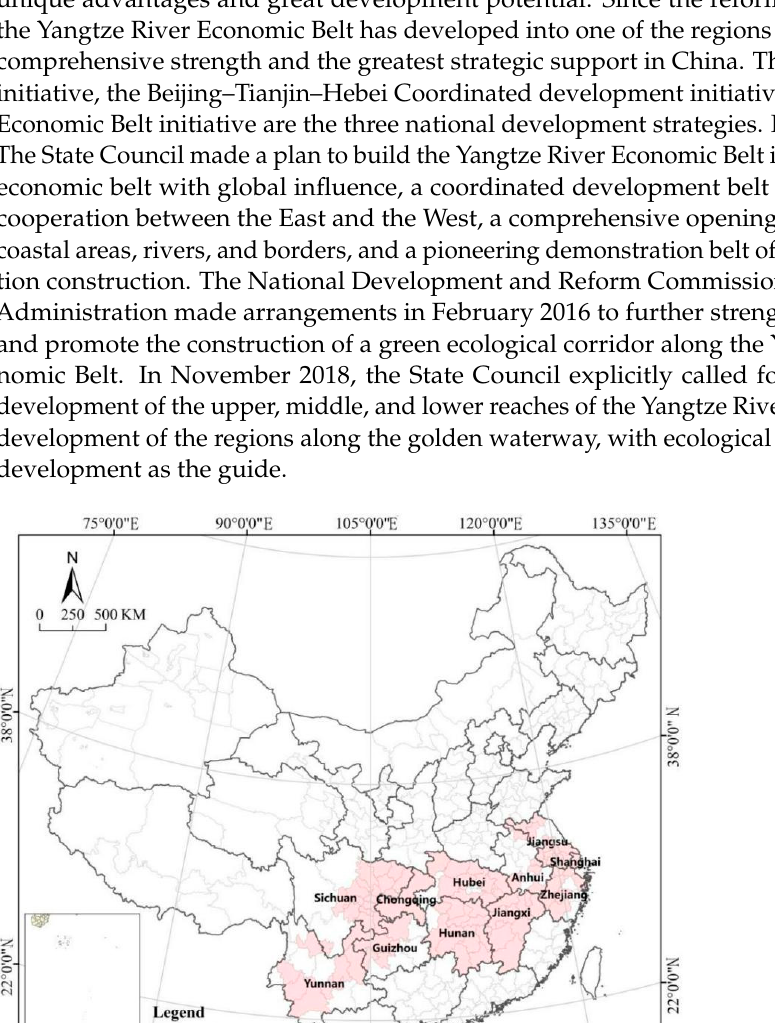
significance and practical value to study its spatial–temporal change and driving